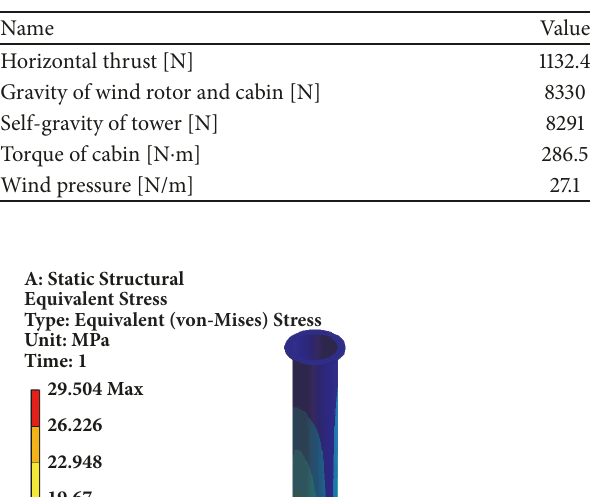
Table 9: Load distribution of tower.